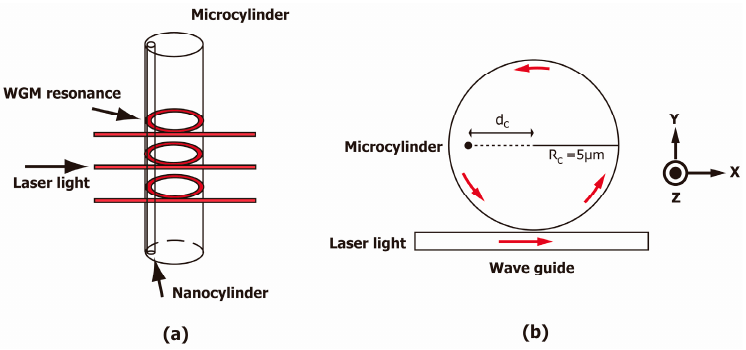
Figure 1. (Color online) Schematic diagram of the microcylinder resonator and bus waveguide ( a ) in 3-D and ( b ) in 2-D. A nanocylinder is located at a distance (cid:1856) (cid:3030) from the